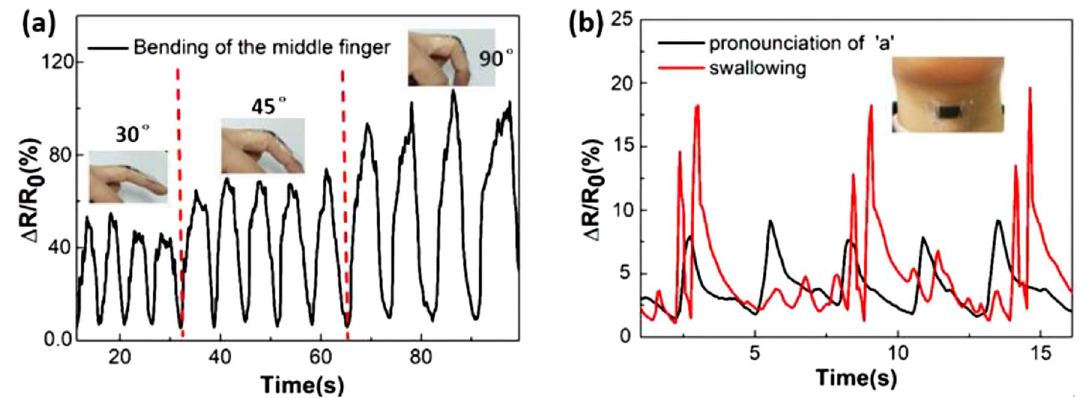
Figure 6. Strain sensor used to monitor human motion. ( a ) Relative change in resistance while bending the strain sensor at joint area of a finger. ( b ) Resistance change in response to pronouncing ‘a’ and swallowing of the